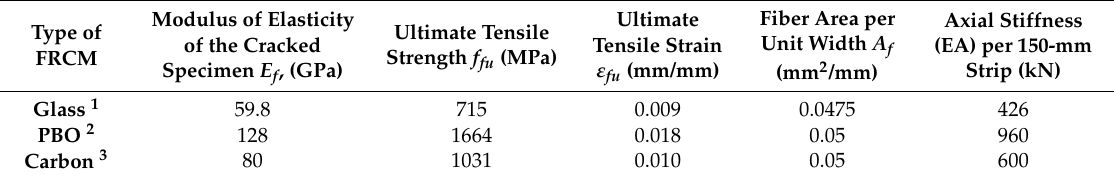
Table 3. Mechanical properties of the FRCM systems.